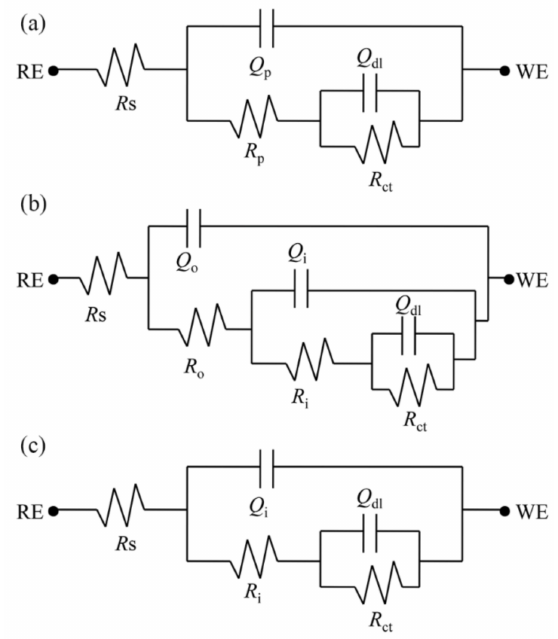
Figure 9. Equivalent circuit models of the pre-treated samples: ( a ) HT and AT samples; ( b ) 5 min to 24 h for PEO sample; ( c ) 48 to 72 h for PEO